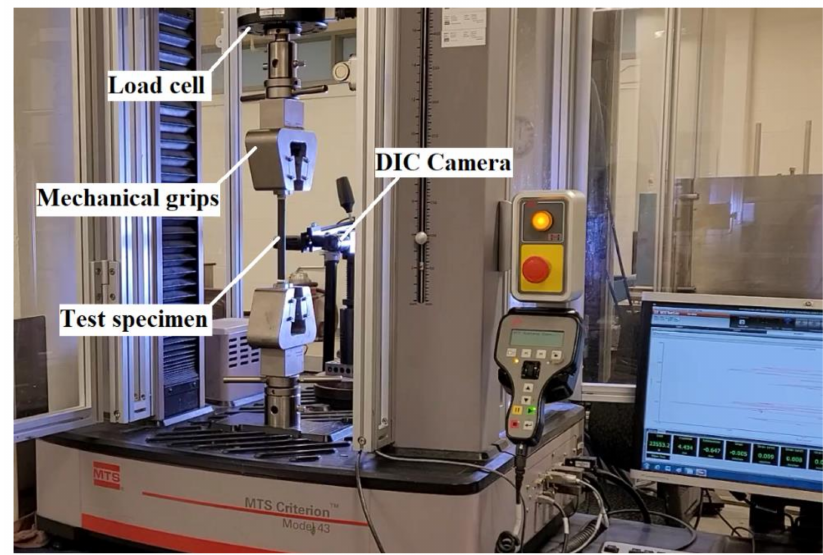
Figure 3. Test setup for material characterization experiments.